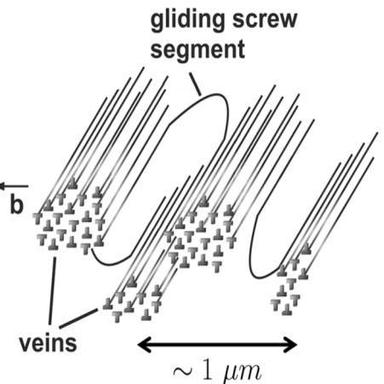
Parametrization of the dislocation loop used to define state variables.